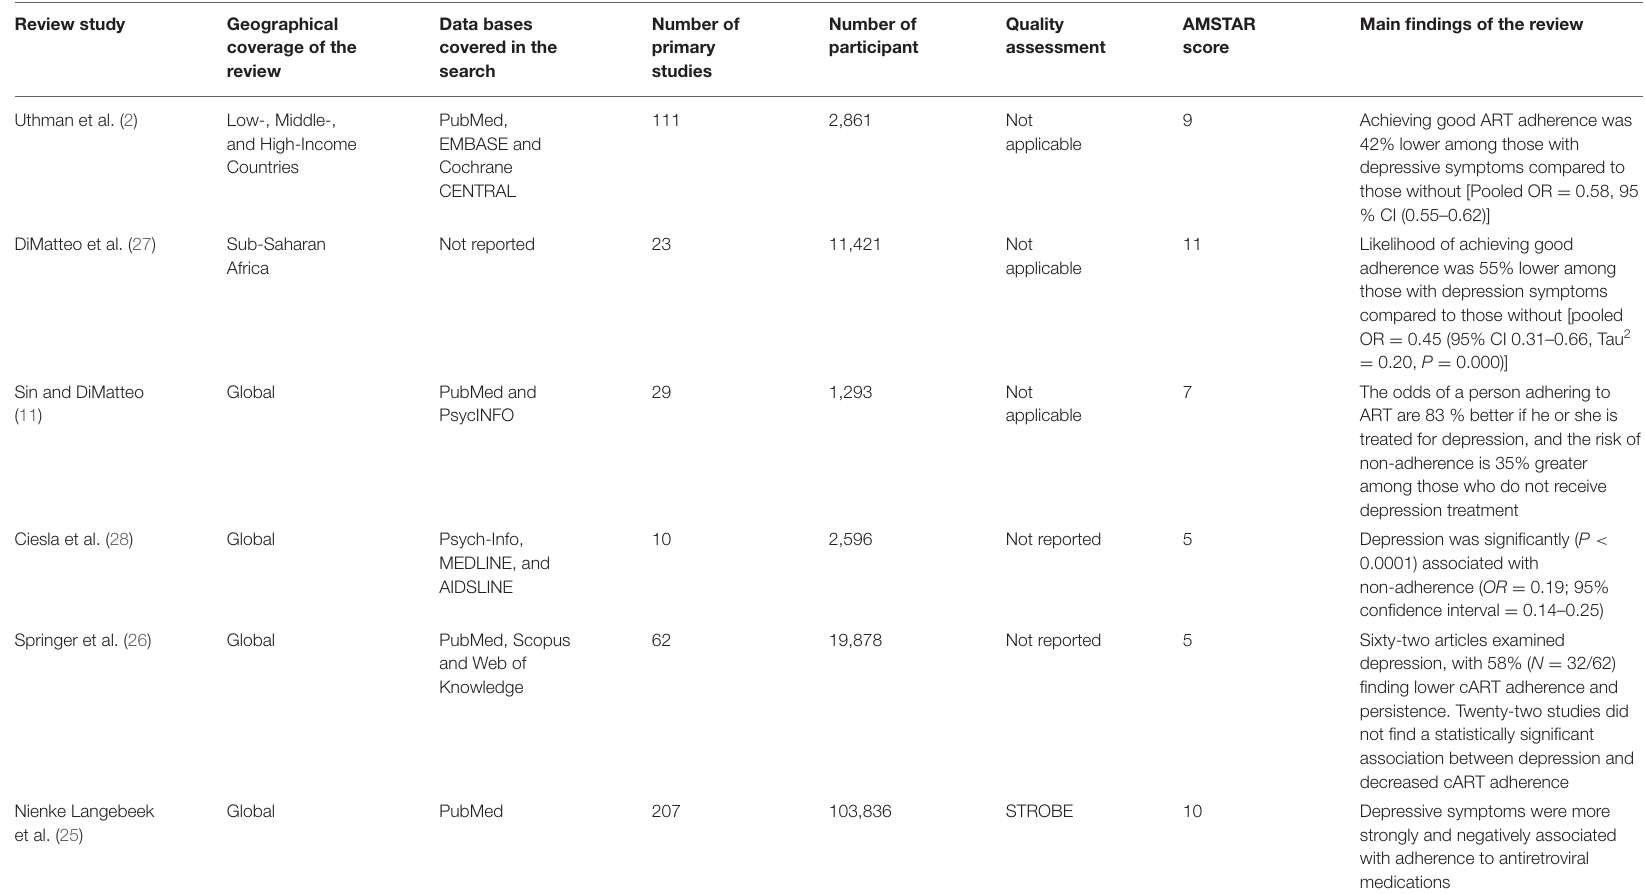
TABLE 3 | Summary of systematic reviews conducted on the effect of depressive symptoms on medication non-adherence among HIV/AIDS patients included in this systematic review of reviews ( N =